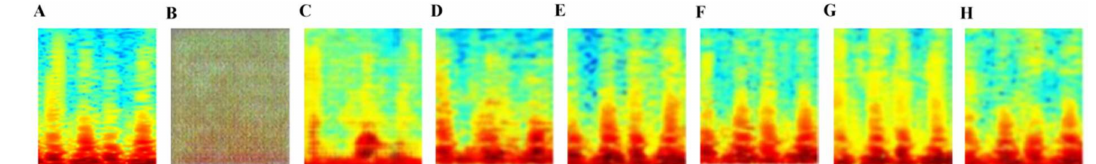
Figure 6. The examples of the spectrogram using the DCGAN model in the LVDD group with an increasing number of epochs: ( A ) original image; ( B ) epoch = 0; ( C ) epoch = 50; ( D ) epoch = 100; ( E ) epoch = 150; ( F ) epoch = 200; ( G ) epoch = 250; ( H ) epoch = 300.